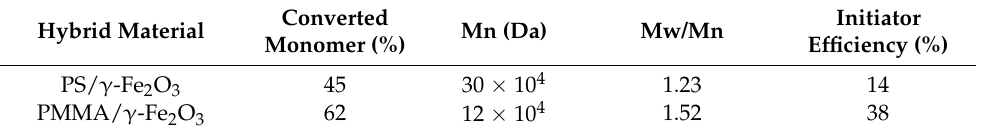
Table 1. Characteristics of the ATRP polymerizations (see Appendix A for details).